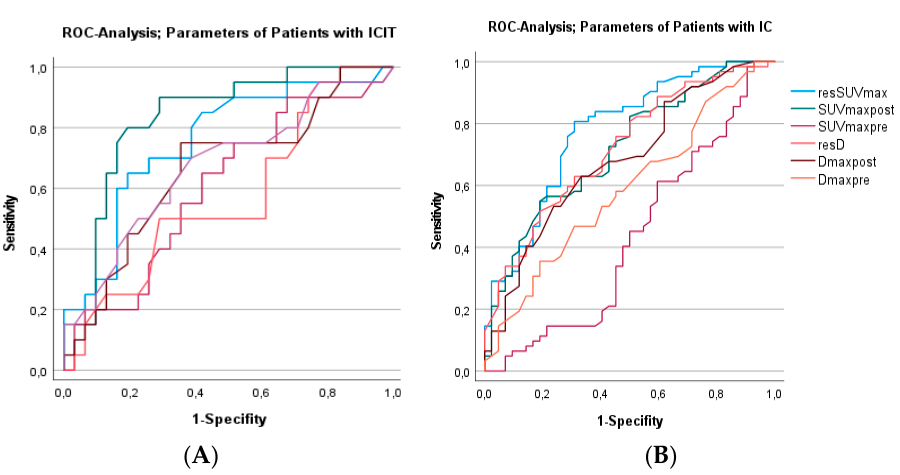
Figure 2. ( A , B ): ROC Analysis of different imaging parameters of 18F-FDG-PET/CT and morphologic imaging (CT/MRI) in patients after one cycle of ICIT (( A ), left) and IC (( B ), right). Sensitivity and specifity for the predefined cut off resSUVmax ≤ 40% ICIT: 90%, 48%, IC: 74%,